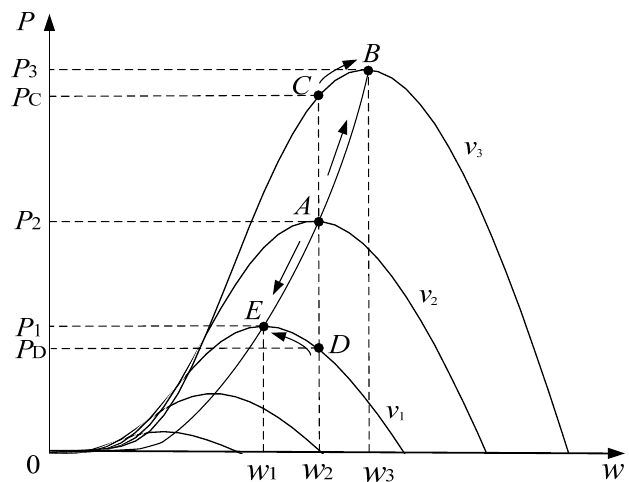
Figure 2. Schematic of the maximum power point tracking (MPPT) method for direct generation power control.